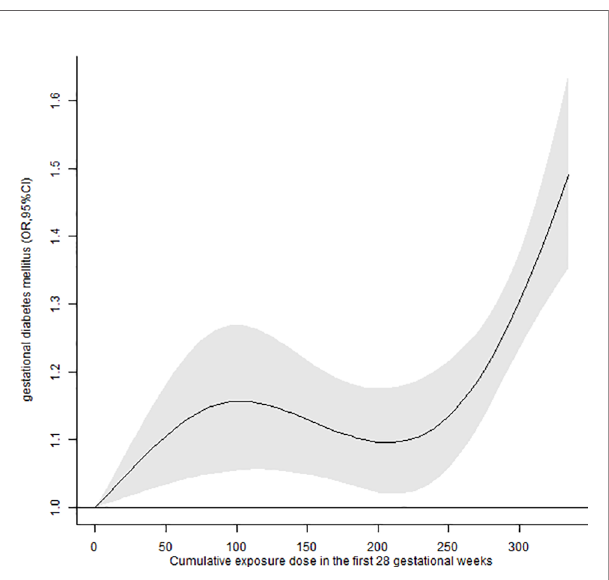
FIGURE 3 | Associations between cumulative exposure dose to lockdown in the fi rst 28 GWs and the risk of